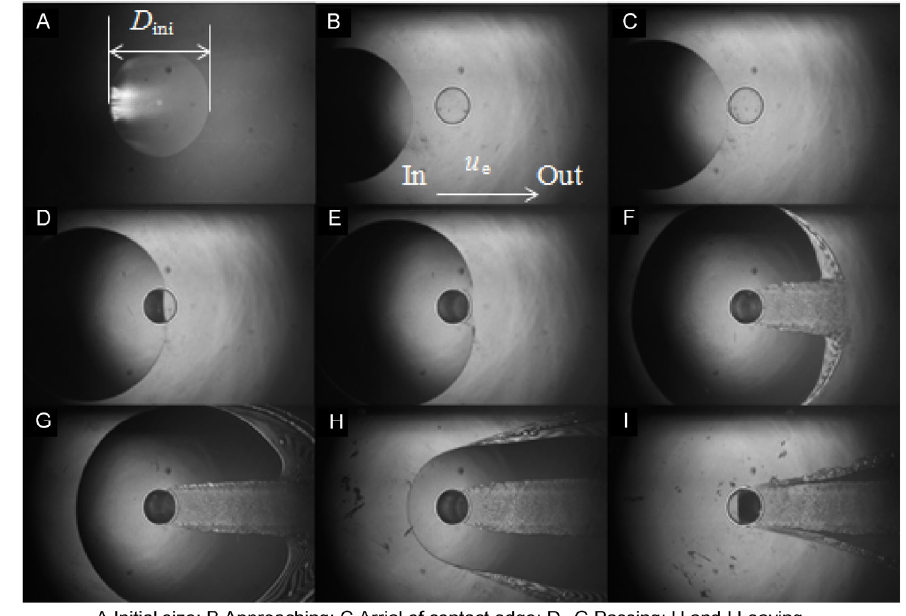
Fig. 9 Droplet passing through the contact region, 5P4E, u e = 0.37 mm/s, w = 30 N, D ini = 1,020 μ